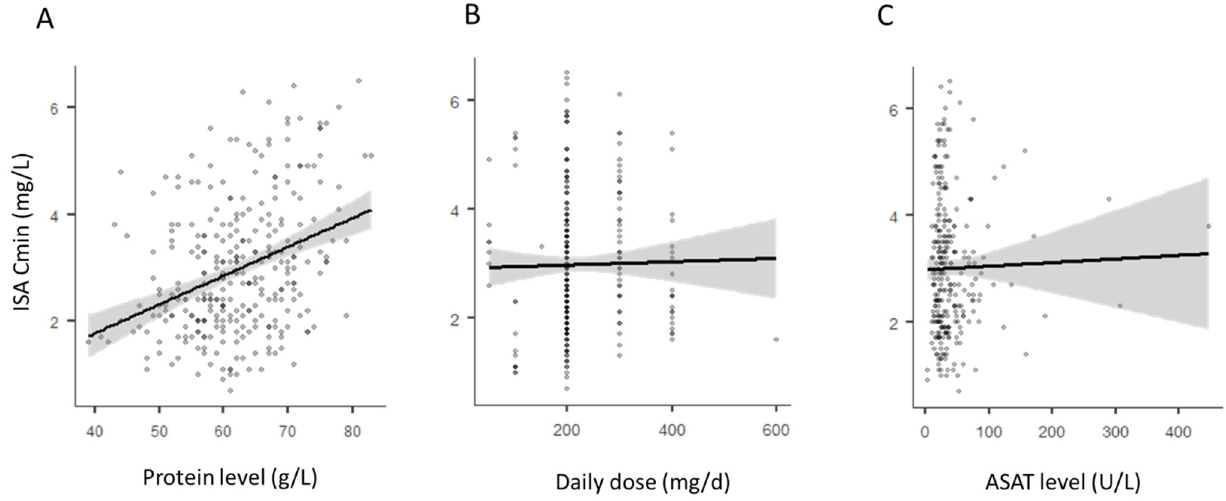
Figure 3. Link between isavuconazole trough concentrations (ISA Cmin) and protein level ( A ), daily dose ( B ) and ASAT level ( C ). dose ( B ) and ASAT level ( C